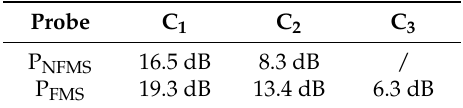
Figure 11. The whole online MFL inspection apparatus for steel pipe.